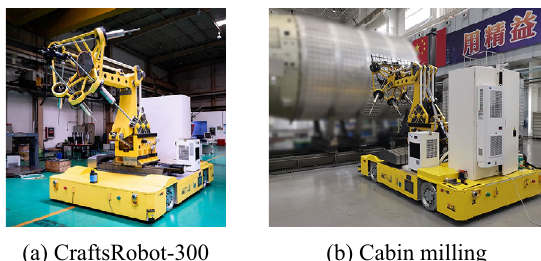
Figure 22 (Color online) Mobile milling robot and its application